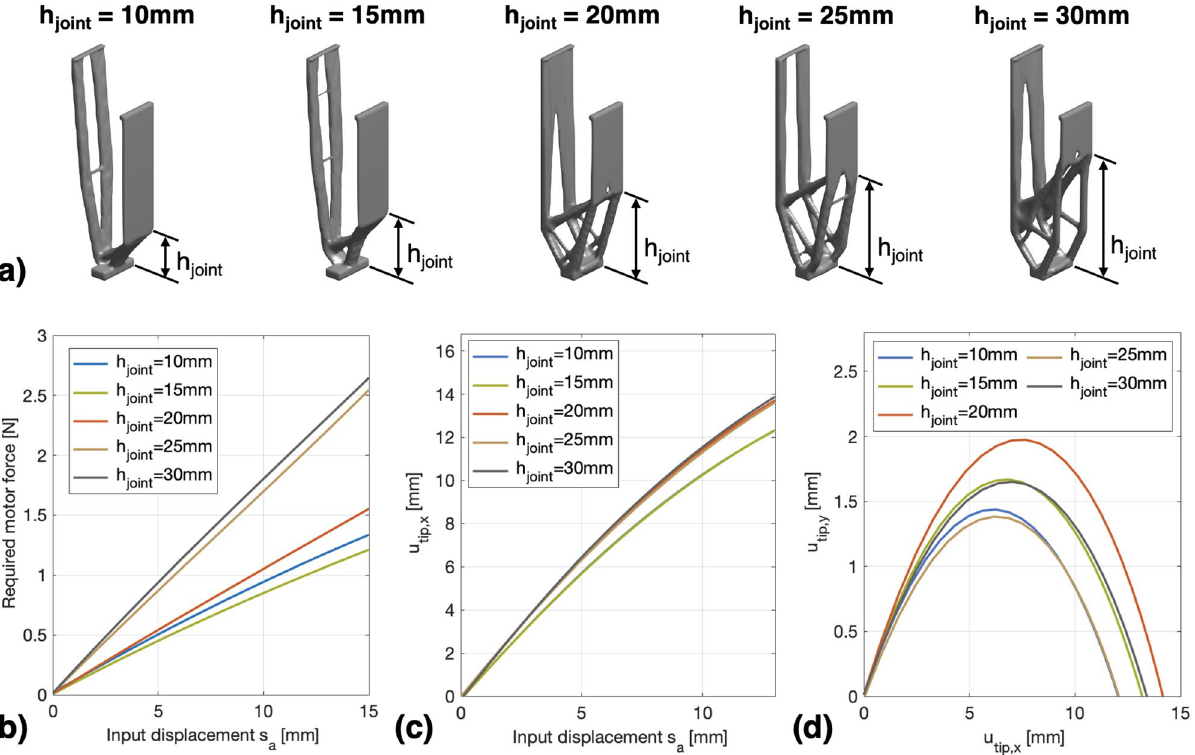
Figure 6. Compliant legs synthesized by using different spring positions h joint : ( a ) The optimized leg shapes, ( b ) FEM-calculated actuation force (in N) for the realized legs, ( c ) FEM-calculated relationship between s a and the induced u tip , x for the realized legs, ( d ) FEM-calculated relationship between u tip , x and u tip , y during the two-stage bending motion of the